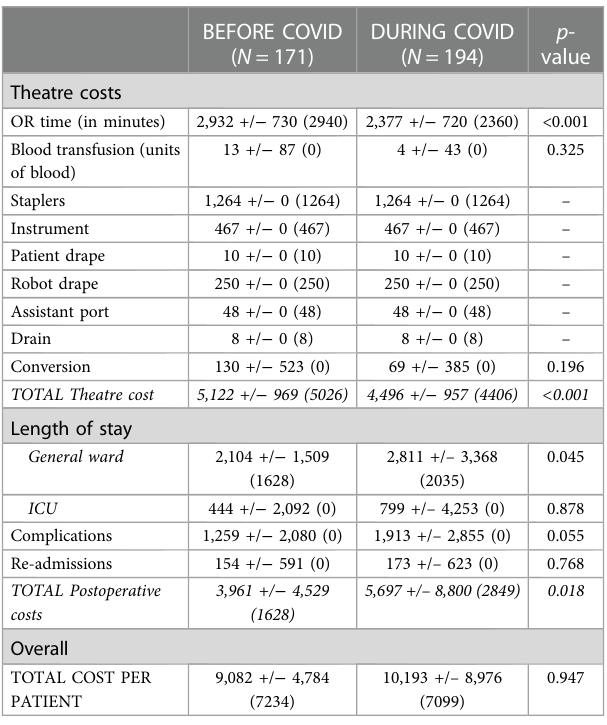
TABLE 8 Effect of the COVID-19 pandemic on